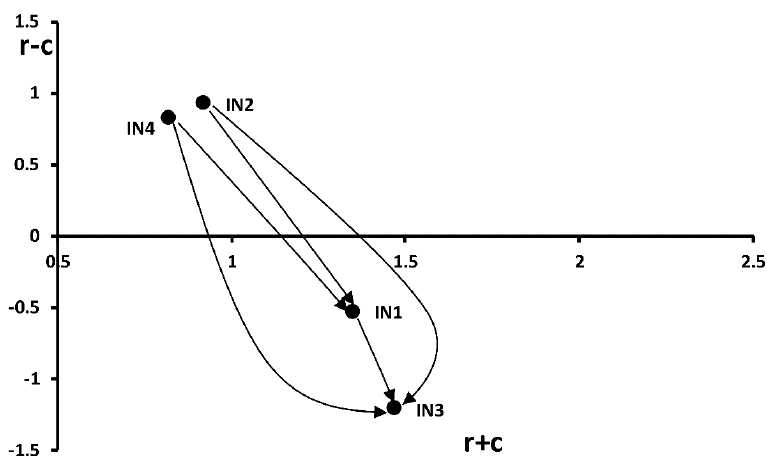
Figure 4. The cause and effect relationship map for instrumentation FMs.